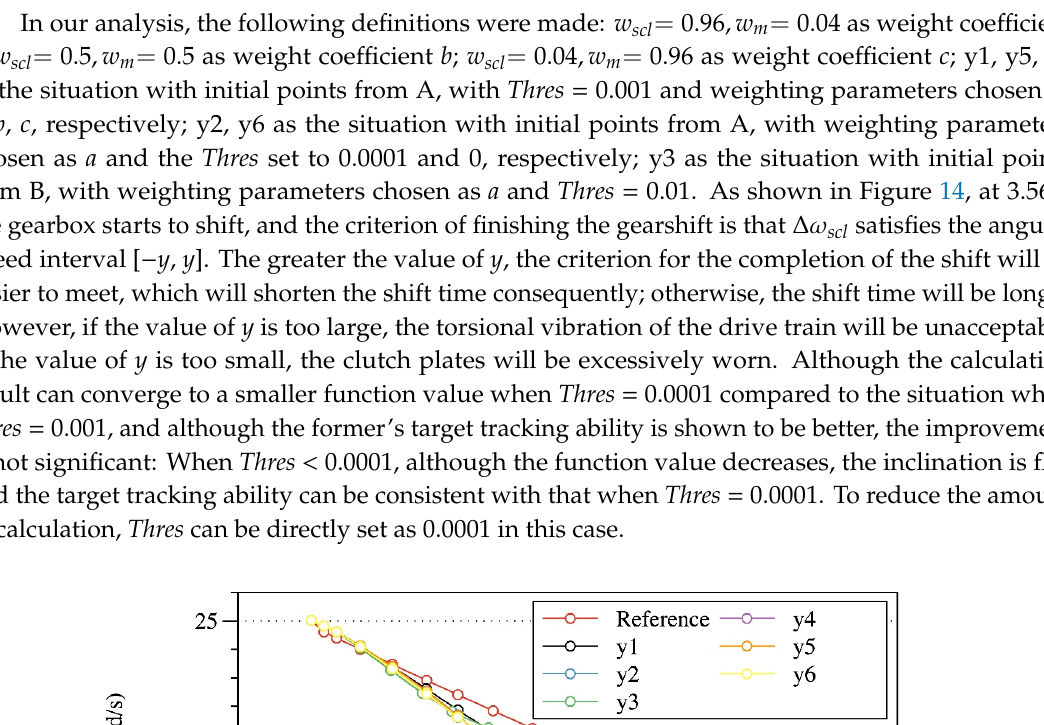
Figure 13. Initial points from matrix B with w scl = 0.96, w m = 0.04 and Thres = 0.001.